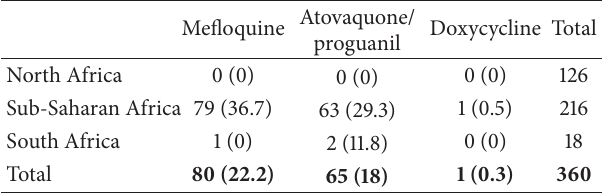
Table 3: Malaria chemoprophylaxis according to destination ∗